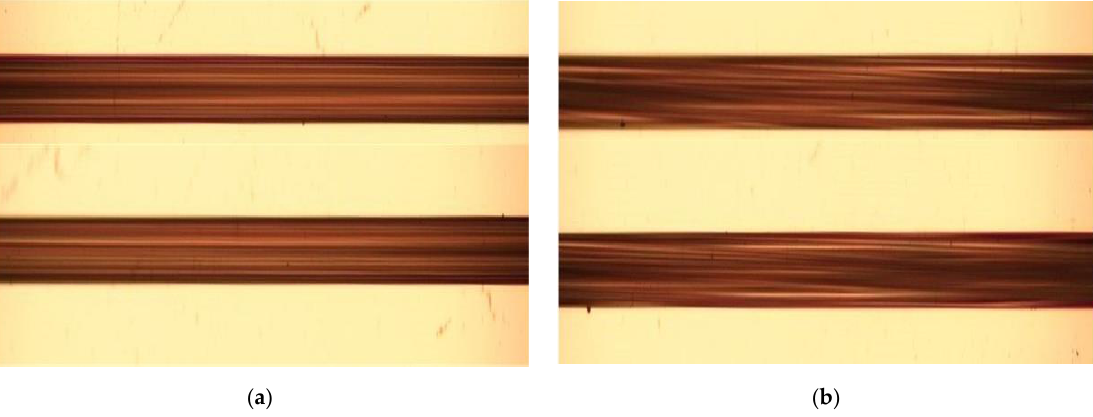
Figure 4. Image of twisted ESSR-MOF fragments: ( a ) 10 revolutions per meter; ( b ) 66 revolutions per meter.